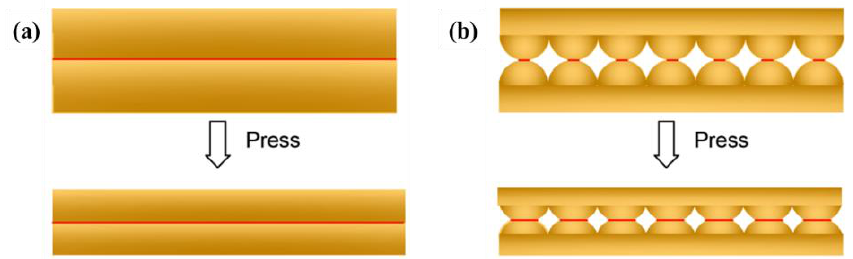
Figure 3. Comparison of deformation between ( a ) non micro – structured sensor and ( b ) micro-structured sensor under pressure.